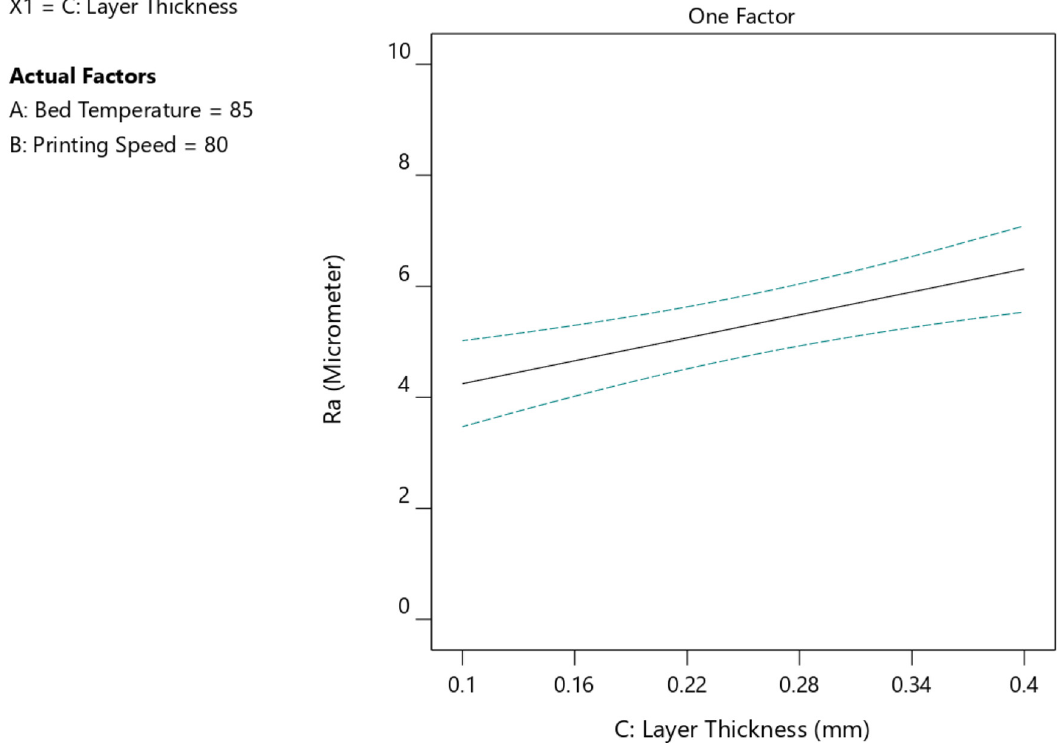
Fig. 8. Main effect plot of layer thickness